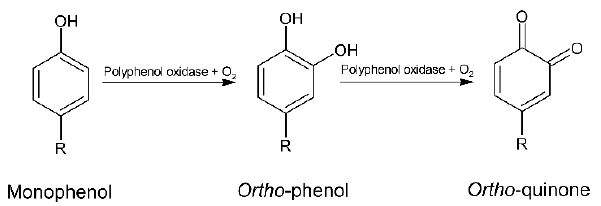
Figure 5. Oxidation of phenols by polyphenol oxidase.